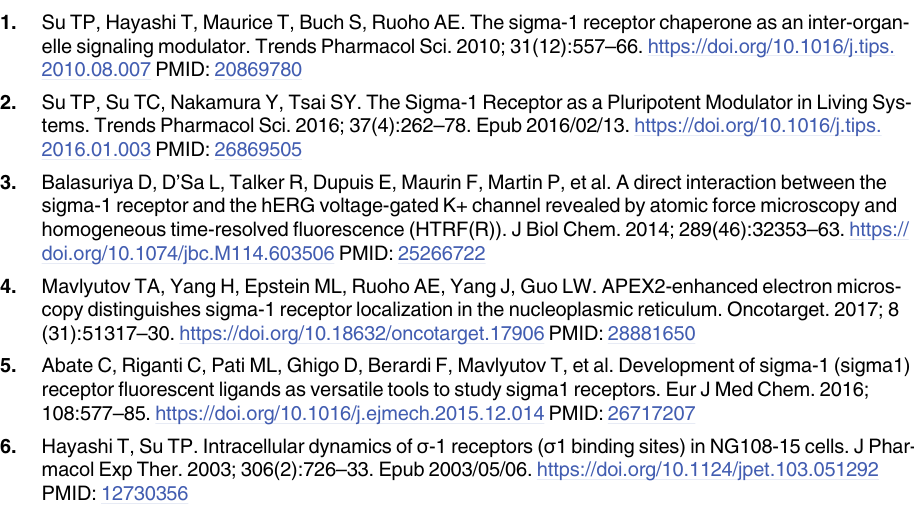
plugin (100 frames per time point [62], magnification: 5, temporal analysis settings: TRPPM). Bright fluorescent spots were automatically extracted using wavelet spot detector in Icy soft- ware [63] and tracked with spot tracking block which relies on Multiple Hypothesis Tracking algorithm [64] (motion mode: directed, optimization: LPsolver, filter out trajectories < 5 frames